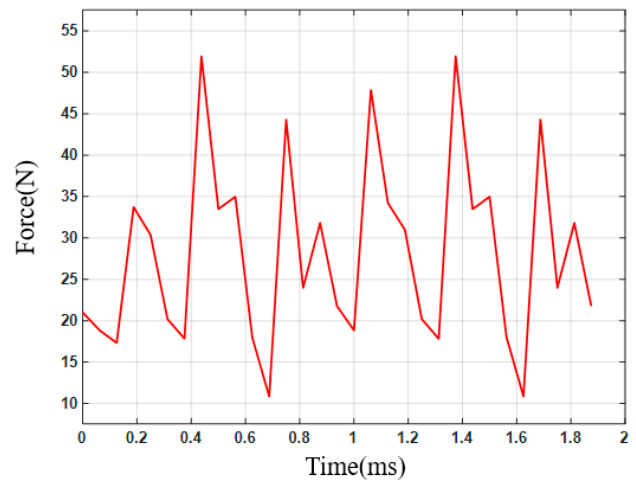
Figure 5. Electromagnetic force time history.